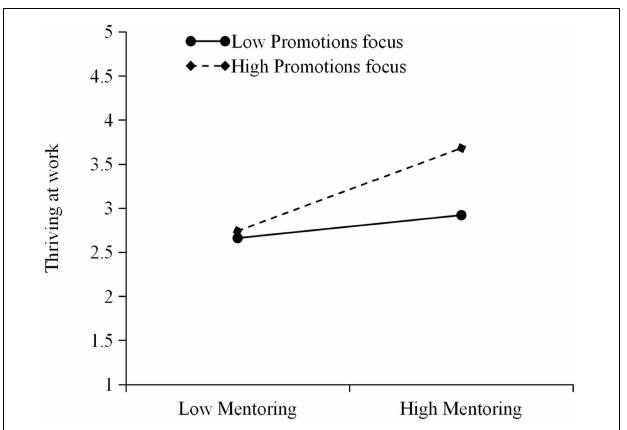
FIGURE 2 | The moderate effect of promotion focus on mentoring and thriving at work.